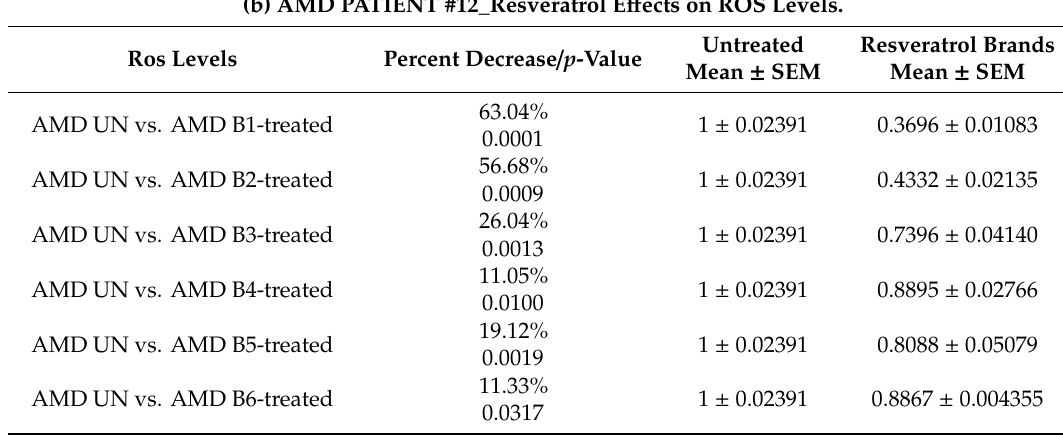
Figure 14. Effects of resveratrol formulations on cell viability ( A ) and ROS levels ( B ) in AMD patient